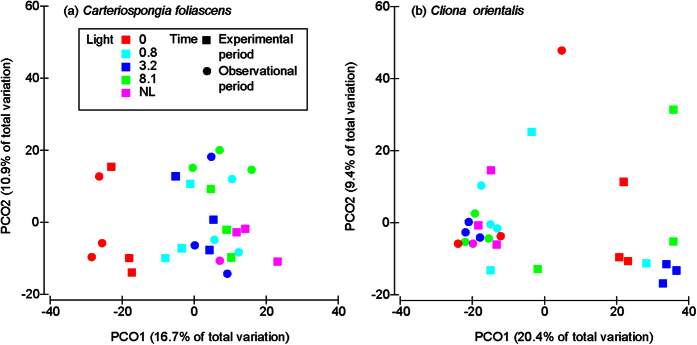
PCO analyses of C. foliascens and C. orientalis.Principal coordinate analysis plots for C. foliascens and C. orientalis which showed significant differences based on light treatment or time according to PERMANOVA analysis (Table 3C). Square symbols represent samples at the end of 28 d experimental period, circles are samples at the end of the observational period and colours indicate the 5 light treatments (0, 0.8, 3.2, 8.1 mol photons m−2 d−1 and natural light: NL, 3.2–6.5 mol photons m−2 d−1).